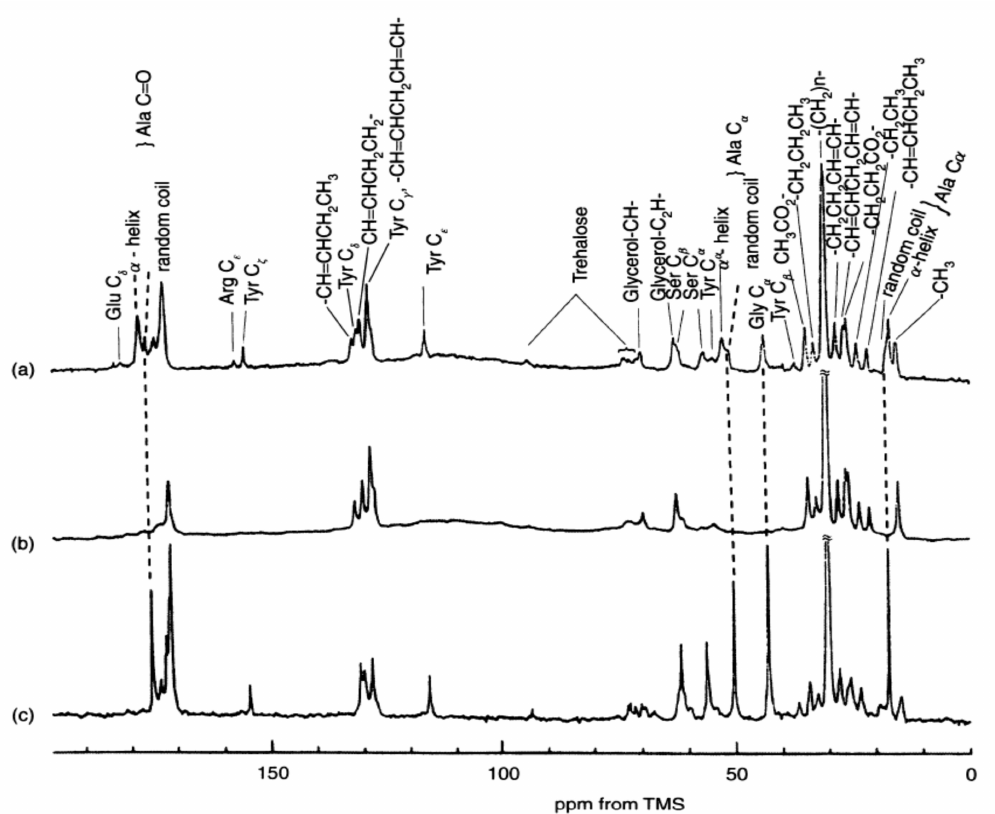
Figure 2. 13 C solution NMR spectra of ( a ) the middle silk gland portion of living Samia cynthia ricini mature larva, ( b ) the abdomen of living S. c. ricini pupa and ( c ) the middle silk gland portion of living Bombyx mori mature larva together with the assignment [39,40]. Reprinted with permission from ref. 39. Modified from ref.